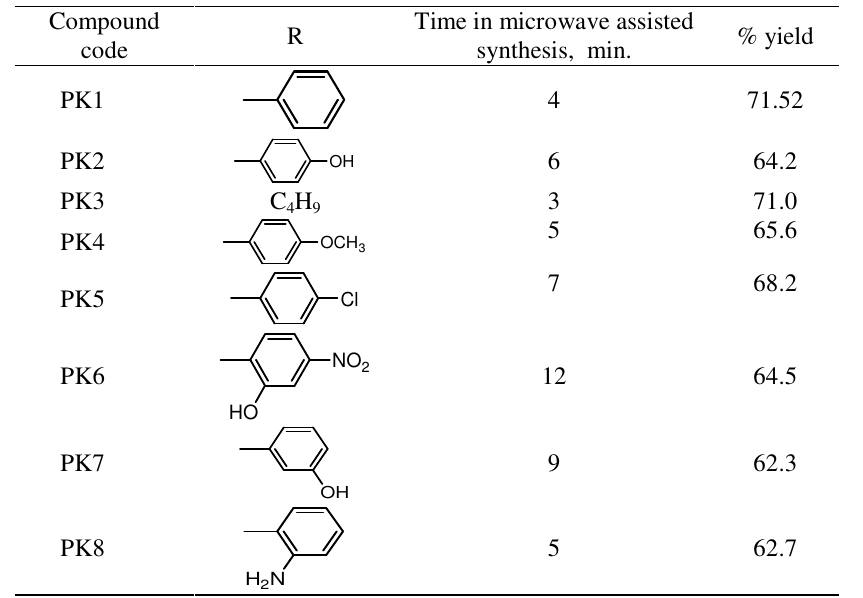
Table1. Structures, time in microwave assisted synthesis and % yield of synthesized